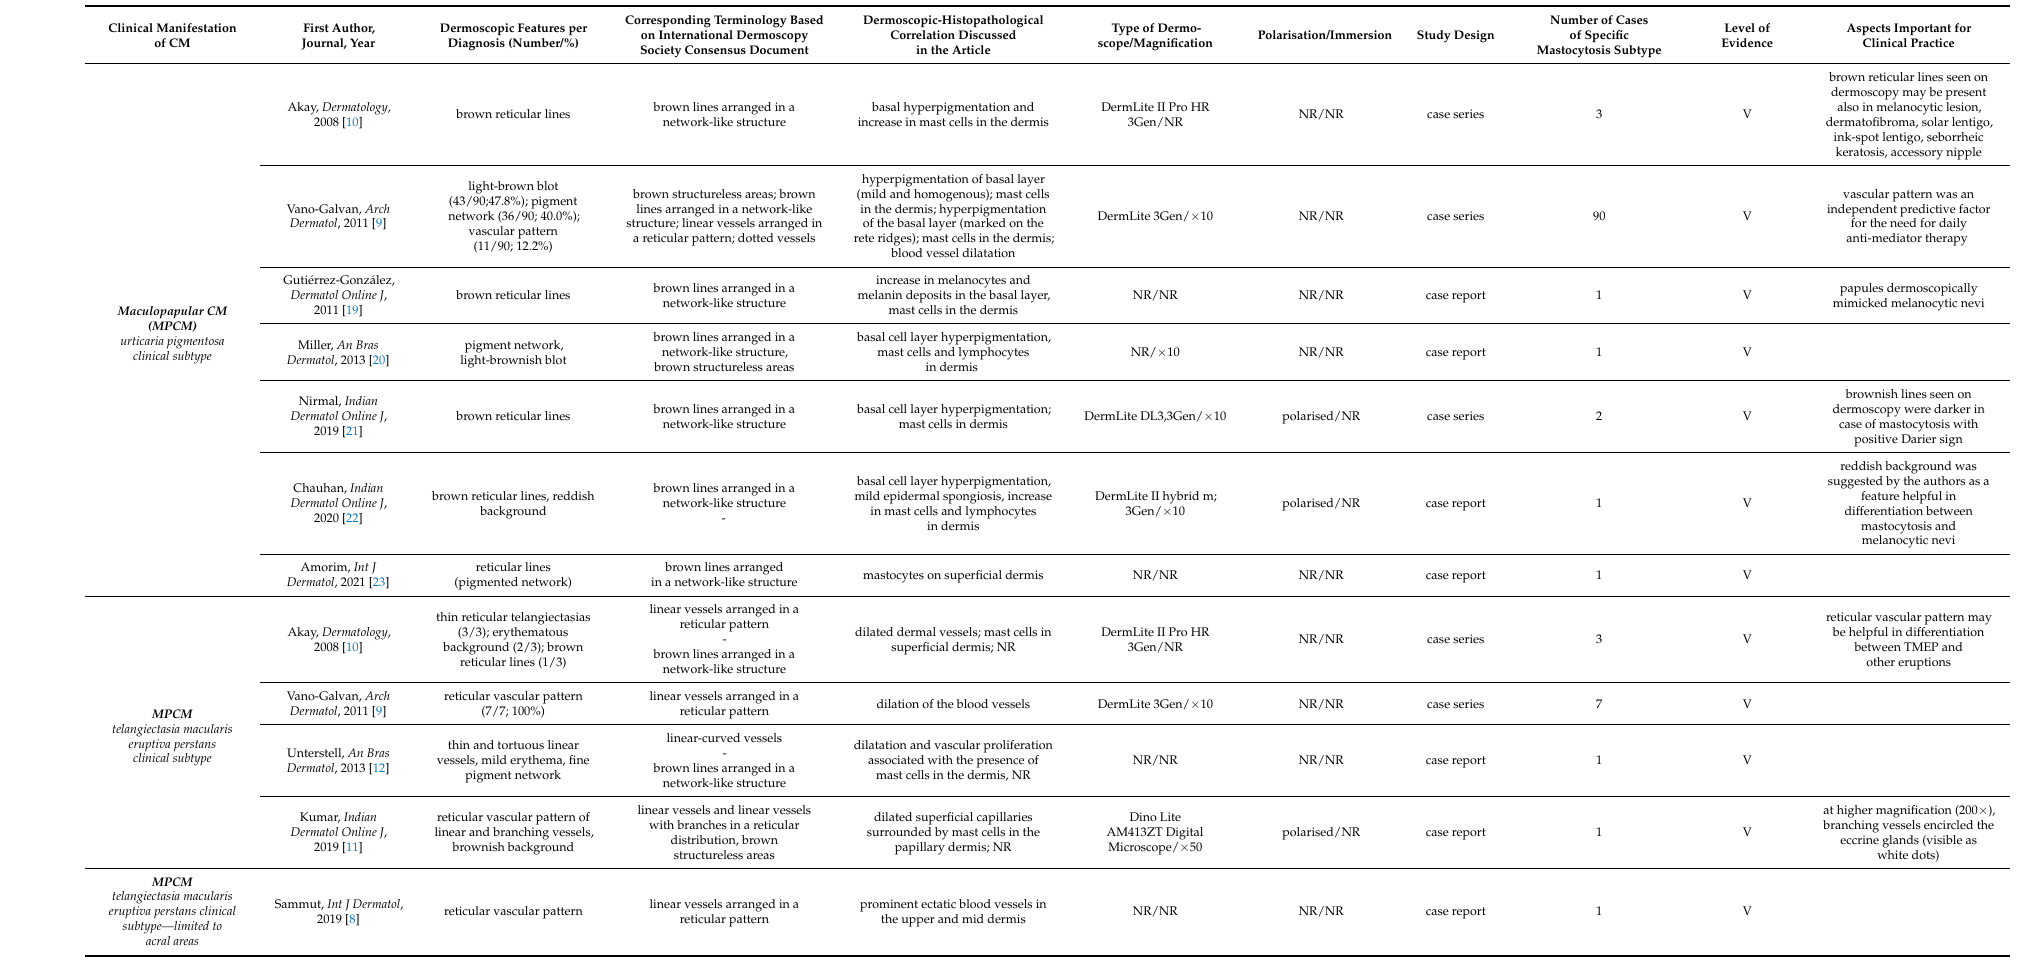
Table 1. The summary of the dermoscopic features for different forms of cutaneous